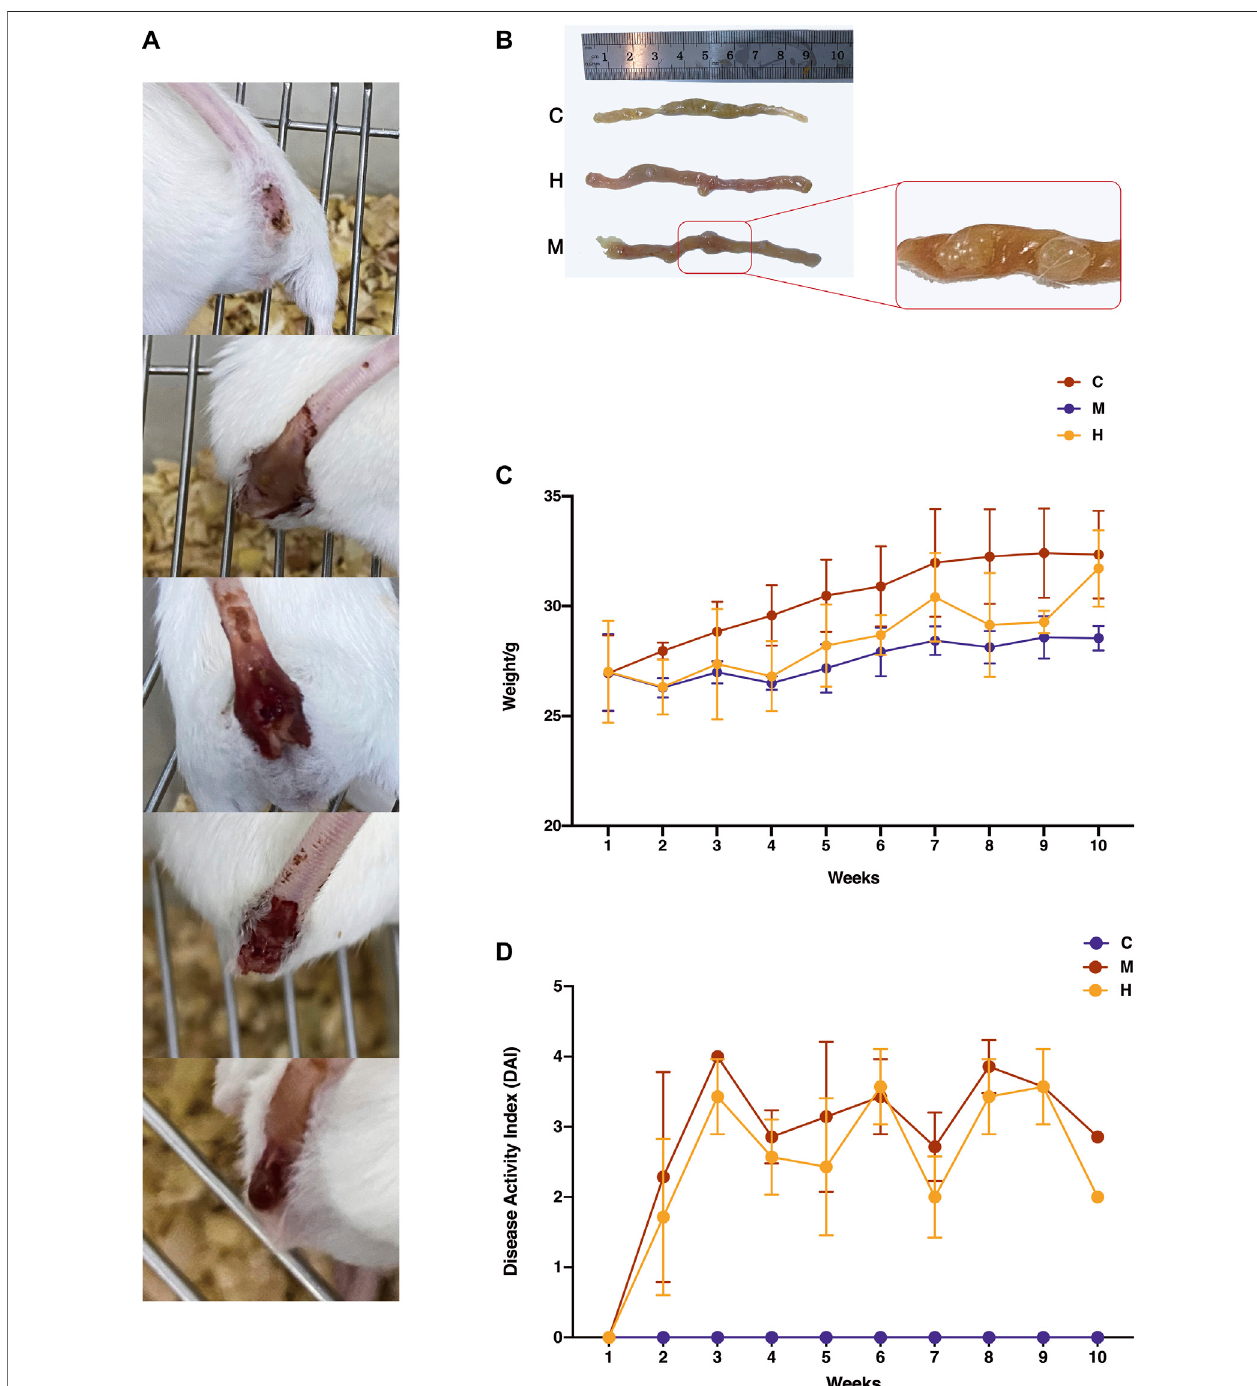
FIGURE 2 | Effect of HQT on AOM/DSS-induced CAC mice. (A) Changes in fecal traits of model mice during the induction of AOM/DSS. As the modeling progressed (shown in the fi gure from top to bottom), mice gradually developed dilute stools, mucus stools, pus, and blood stools and fi nally detached and developed tumors. (B) ChangesincolonictissuesofmiceduringAOM/DSSinduction.C:Normalcontrol(dailygavageofequalvolumeofsaline);M:modelcontrol(combinedAOM/ DSS induction, daily gavage of equal volume of saline); and H: HQT control (combined AOM/DSS induction, daily gavage of 20 g kg − 1 HQT). The number and size of tumors in the HQT group were smaller than those in the model group. (C) Body weight changes in mice during AOM/DSS induction. The weight of mice dropped sharply after the fi rst administration of DSS and regained weight after theadministration ofHQT. (D) DAI scores ofmice during AOM/DSSinduction. The results showed that HQT groups had lower scores than the model